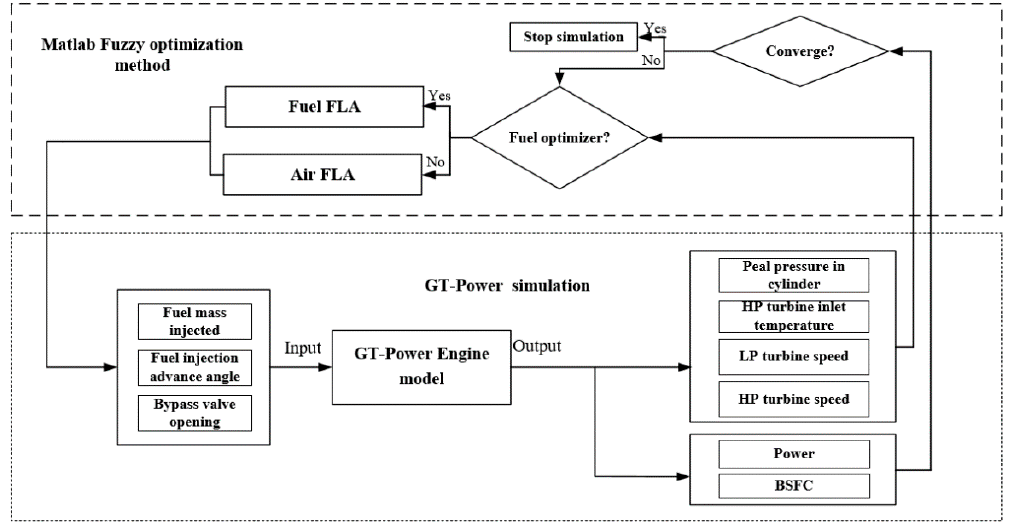
Figure 8. Co-simulation model.